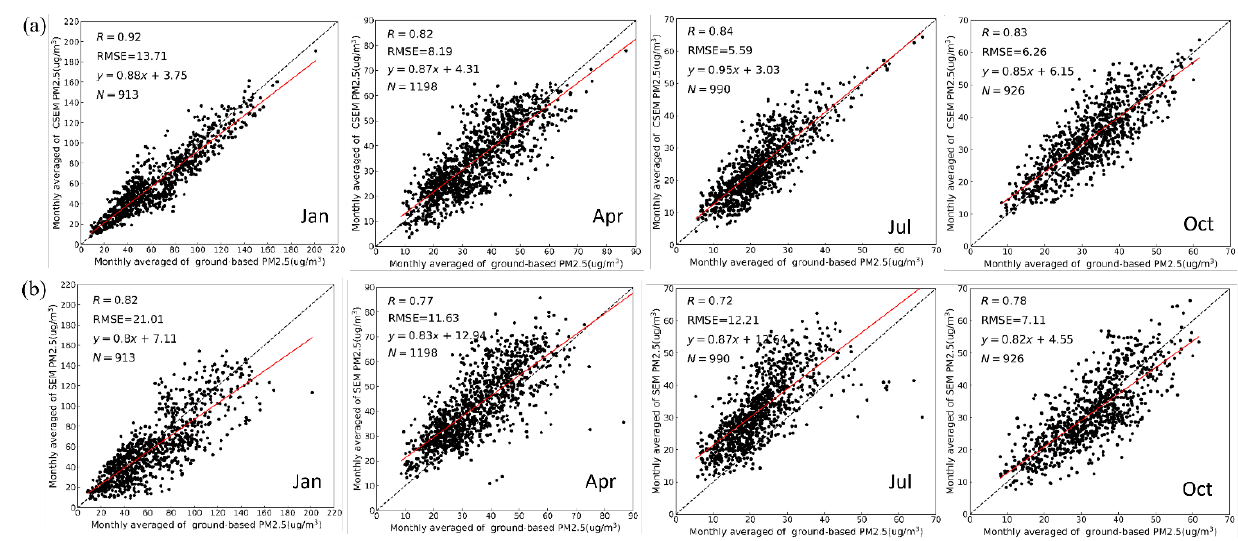
Figure 5. Spatial correlation coefficients between the monthly (January, April, July, and October) average of the evaluated PM 2.5 average and ground-based PM 2.5 are estimated (( a ) CSEN; ( b ) SEM). Table 1. Comparison of the CSEN, SEM, and WRF-chem model performances.